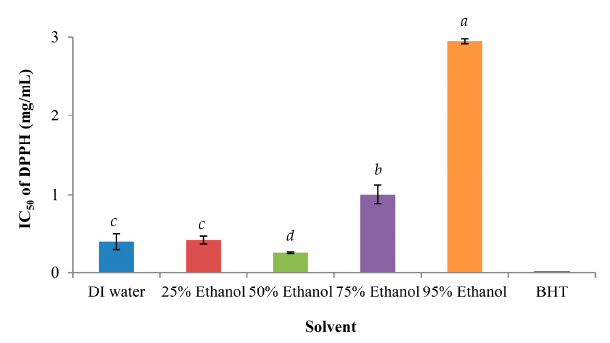
Figure 2. IC 50 of jujube peel pulp extracted using various extraction solutions at 60 ◦ C. The error bar represents the standard error of the mean. Solvents in the histogram with the same letter were not significantly di ff erent at the 5% level, according to the results of the least significant di ff erence (LSD) test.